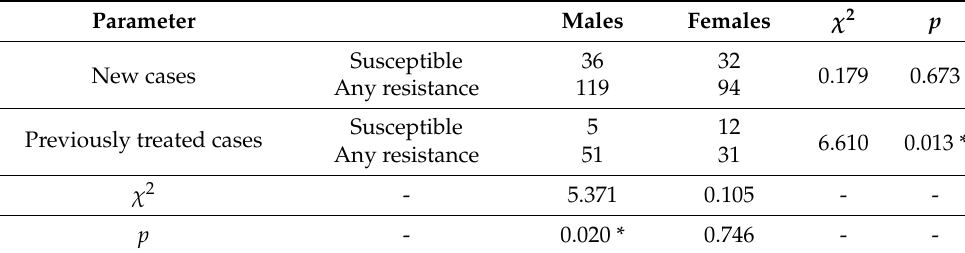
Table 3. Cross analysis table of treatment type, gender and drug resistance.